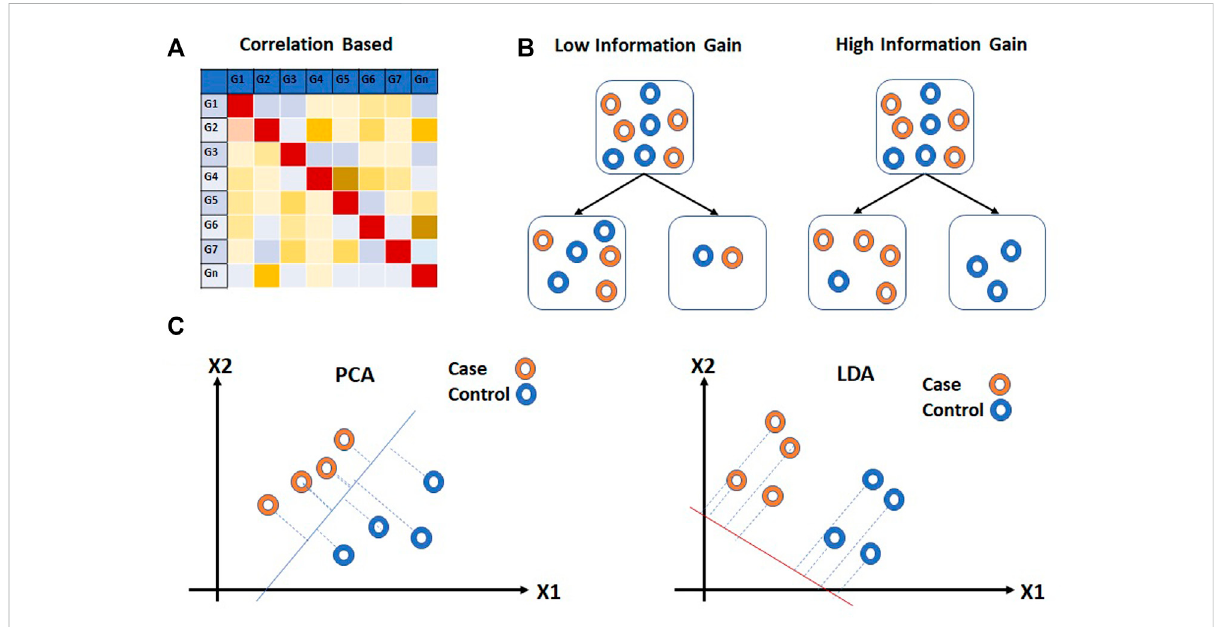
FIGURE 6 Filter approaches for feature reduction. (A) Correlation based feature selection (CFS) and (B) Information Gain (IG) are feature selection approaches for feature reduction. (C) Principal Component Analysis (PCA) and Linear Discriminant Analysis (LDA) extract information from multiple feature genes. Hollow circles in (B,C) represent